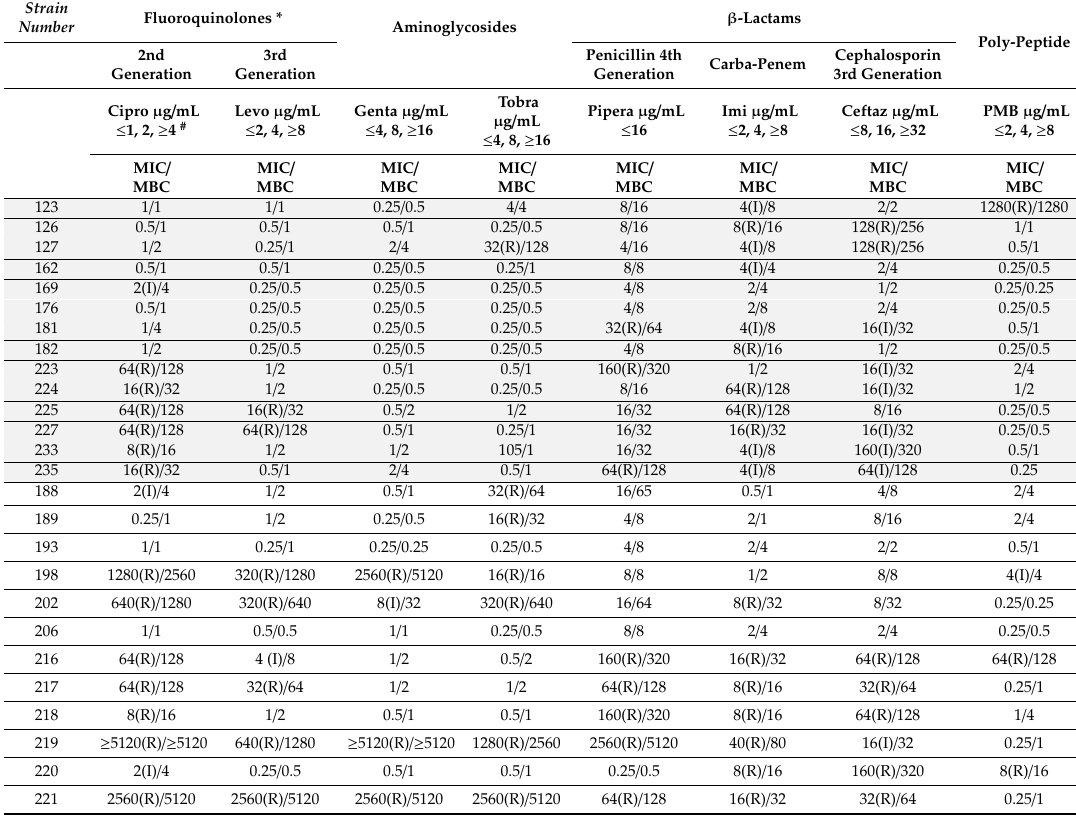
Table 1. Minimum inhibitory concentration (MIC) and minimum bactericidal concentration (MBC) of antibiotics to Pseudomonas aeruginosa keratitis